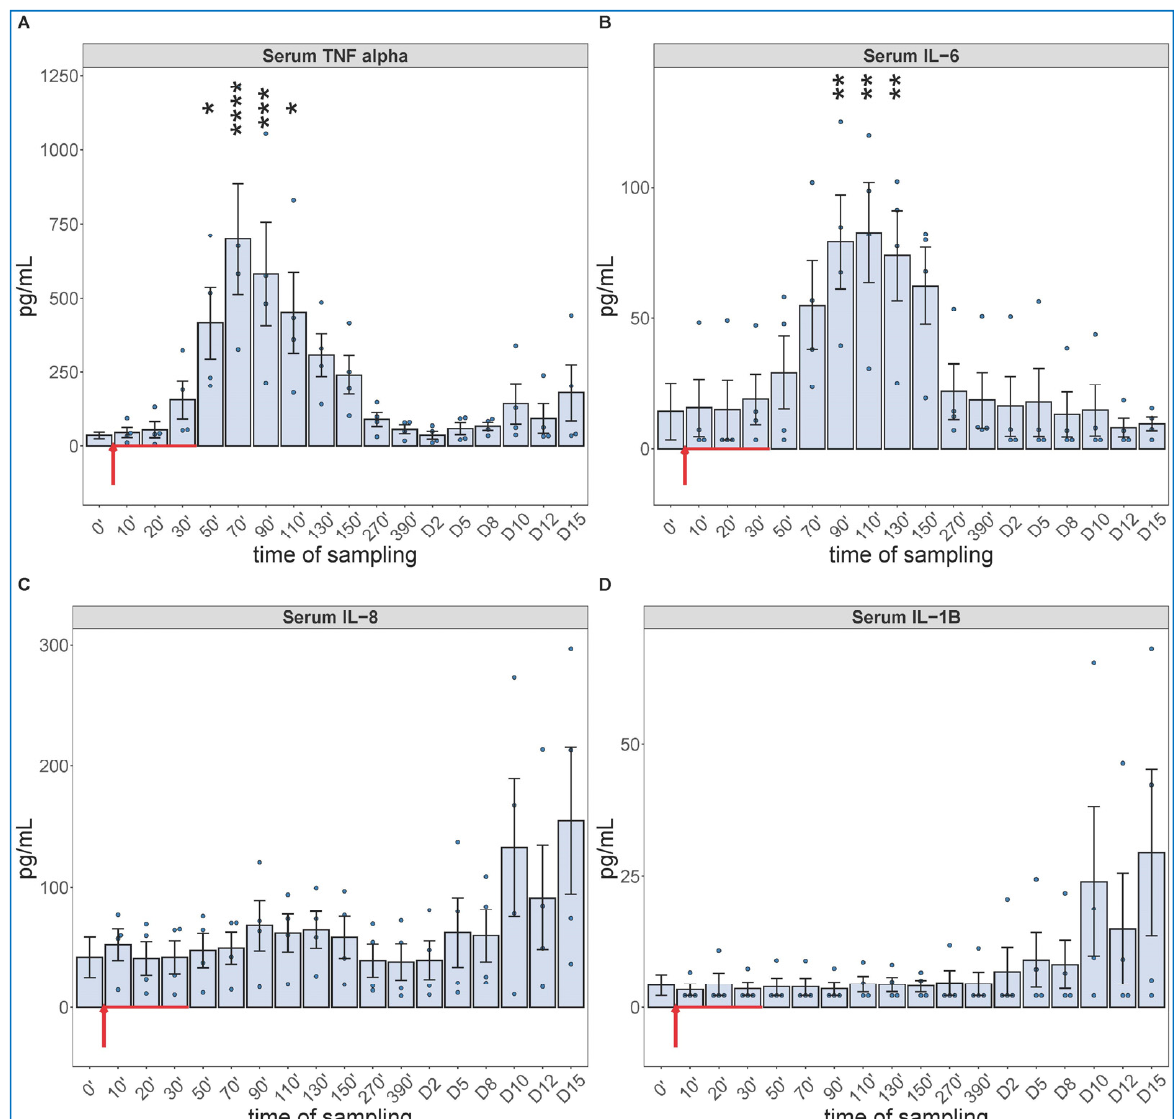
Figure 5. Serum TNF-alfa ( A ), IL-6 ( B ), IL-8 ( C ) and IL-1B ( D ) levels at different sampling times (ELISA). Zymosan administration is marked with red arrow. ANOVA, with Dunnett’s multiple comparison test, compared to respective baseline (0’) controls, * p < 0.05 vs. 0’; ** p < 0.01 vs. 0’; *** p < 0.001 vs. 0’; **** p < 0.0001 vs. 0’.